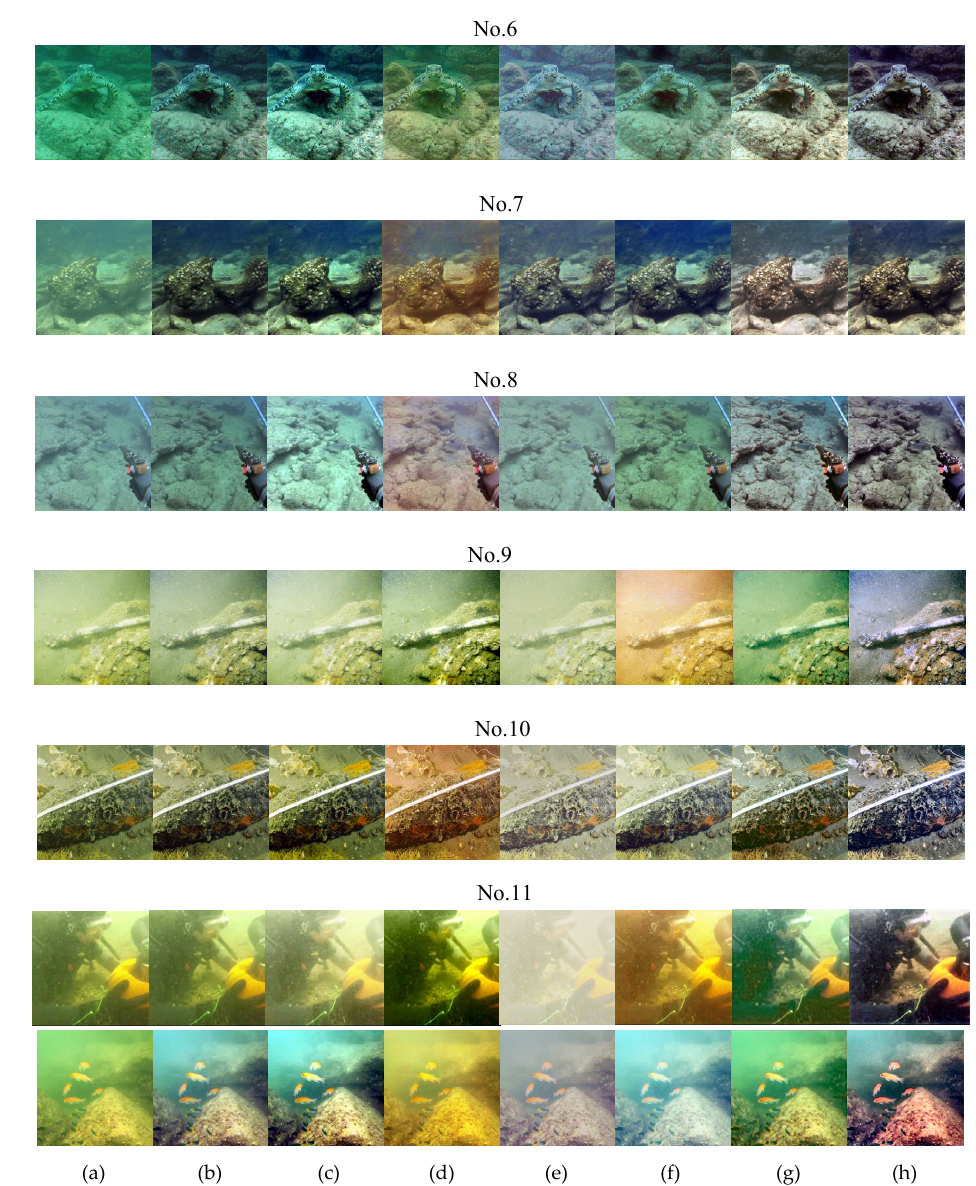
Figure 9. Processed results of images from UIEB dataset. ( a ) Underwater images from UIEB dataset; ( b ) processed by ICM [39]; ( c ) processed by RCP [11]; ( d ) processed by RGHS [40]; ( e ) processed by MSRCR [41]; ( f ) processed by FUnIE-GAN [42]; ( g ) processed by UIE-CNN [43]; and ( h )